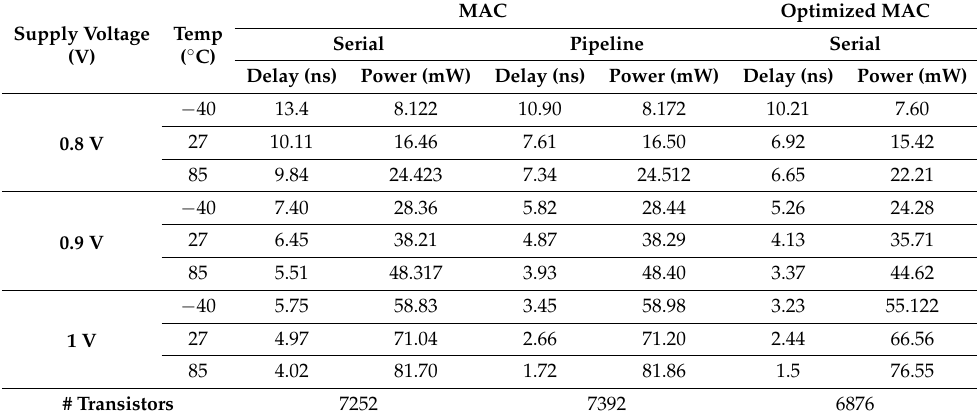
Table 6. Power and delay analysis of the proposed MAC designs for different power supply voltages and